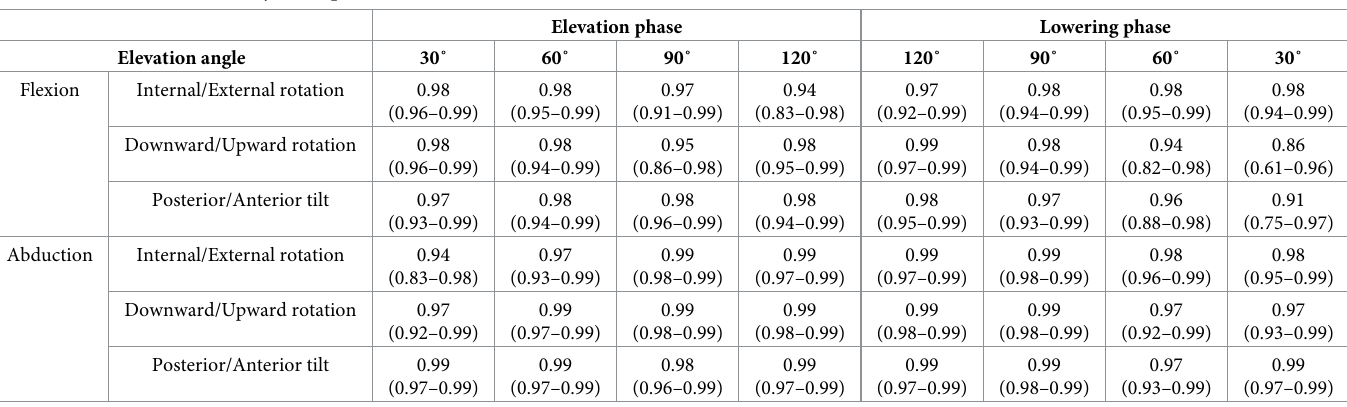
Table 1. Measurement reliability for scapular